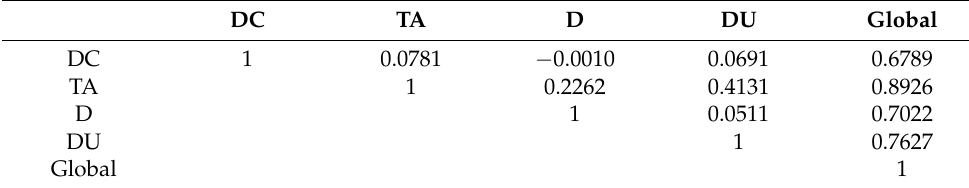
Table 6. Pearson correlations between the subscales and with the global